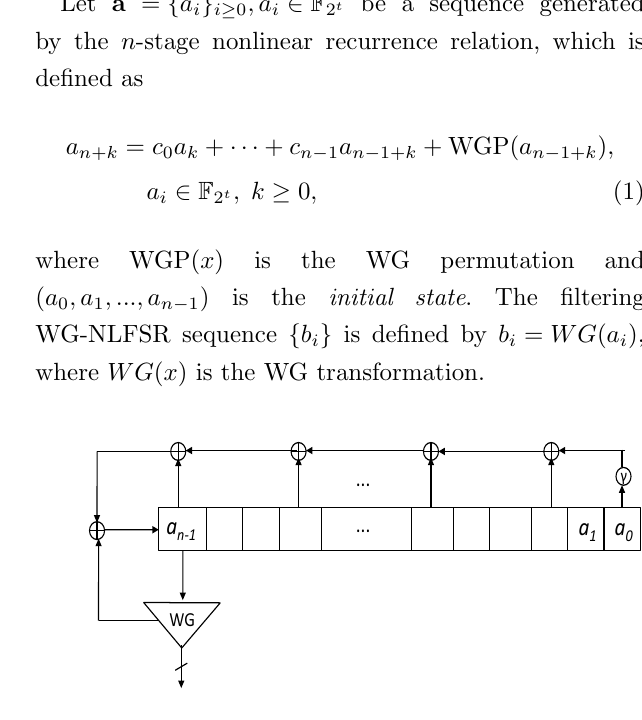
Figure 1. Architecture of the Filtering